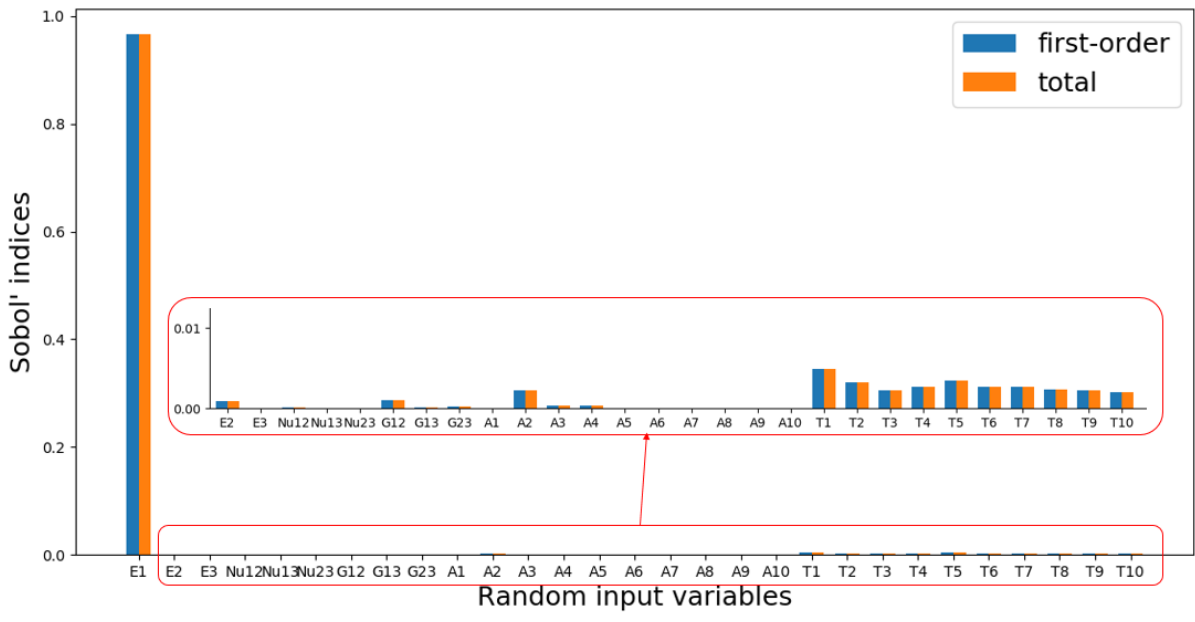
Figure 8. The first-order and total Sobol ’ indices.